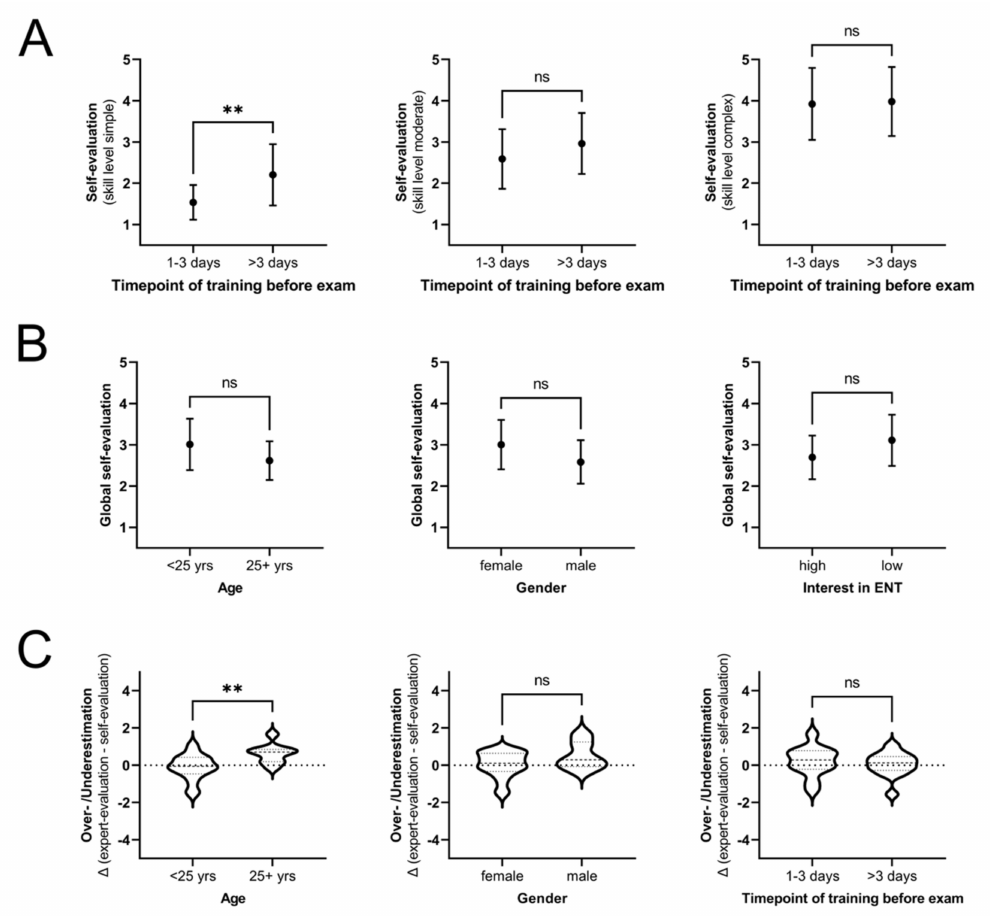
Figure 5. Comparison of self-evaluation and over/-underestimation in different subgroups. ( A ) Self- evaluation in different skill levels; timepoint of completion of the online training was used to define subgroups. ( B ) Global self-evaluation in different subgroups according to age, gender and interest in ENT is shown. ( C ) Global over- and underestimation is compared in age groups < 25 years and 25+ years, female vs. male and in subgroups according to completion of online training. ** p < 0.005; ns p > 0.05 (not